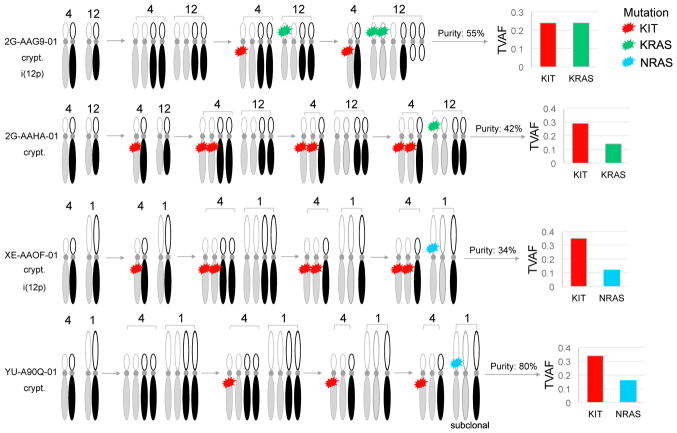
Inferred Order of Somatic Mutations and DNA Copy Number Alterations in TGCTsFour seminomas with co-existing somatic mutations in KIT, KRAS, and NRAS were selected. The timing of somatic events within each sample was inferred by integrated analysis of mutation multiplicity, allelic integer copy number, and whole-genome doubling status. Mutation multiplicity (sq) was calculated from purity, total copy number (CN), and tumor variant allele fraction (TVAF) as follows: sq = TVAF[(CN*purity)+(2*(1–purity))]/purity. Integer copy number, whole-genome doubling status, and purity of tumor genomes were calculated using the ABSOLUTE algorithm. Cryptorchidism (crypt), isochromosome 12p [i(12p)]. Gray and black identify homologous chromosomes.